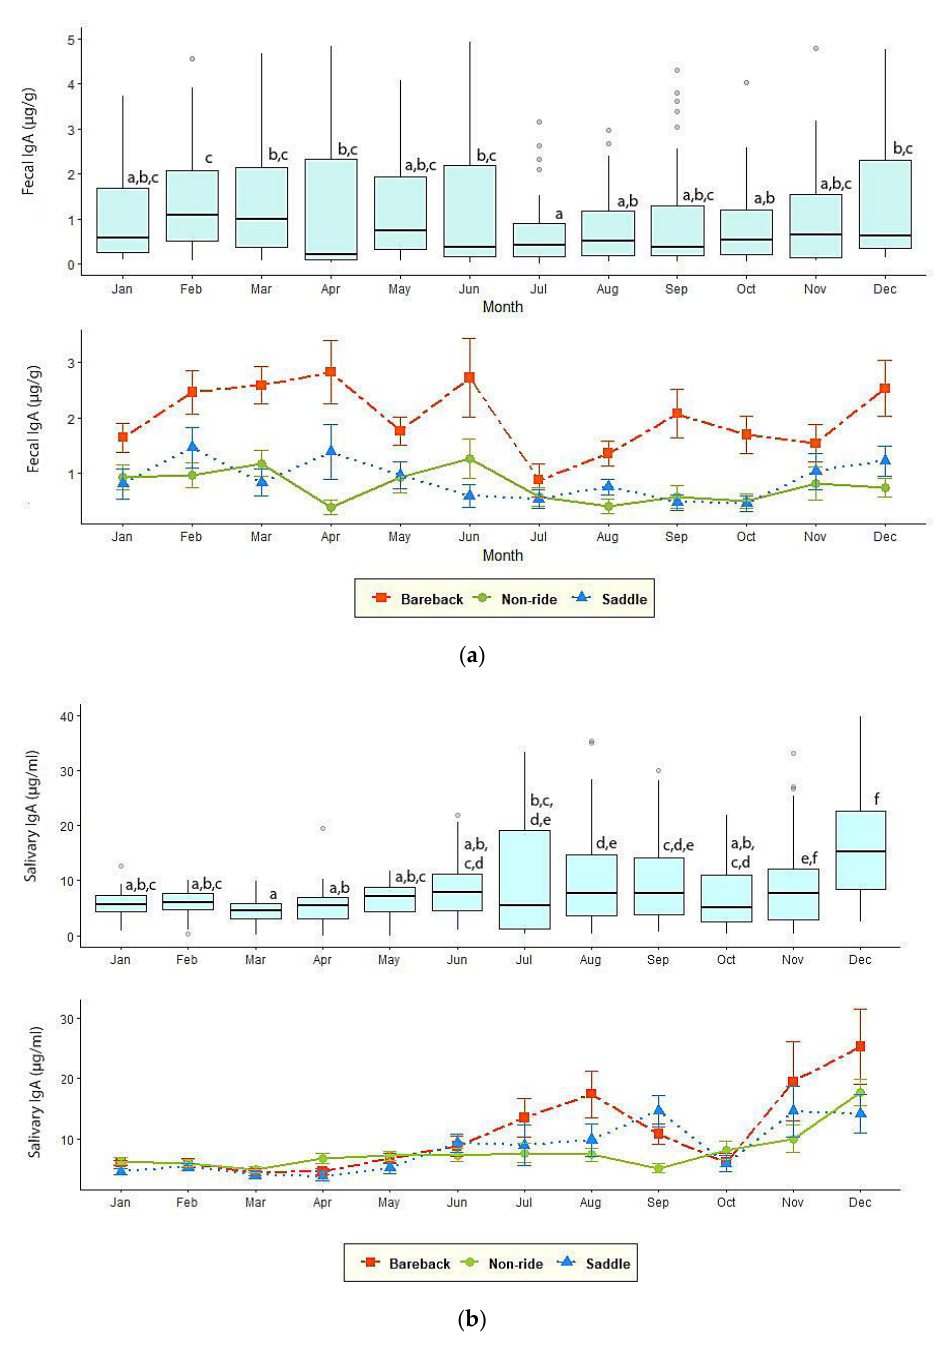
Figure 2. Mean (±SEM) of ( a ) fecal (µg/g) and ( b ) salivary (µg/mL) IgA concentrations in each elephant activity group. Box plot showed overall fecal and salivary IgA measures in combination with three elephant groups (N = 44). Whiskers represent median, quartiles, and the 25th/75th percentiles, error bars represent the 10th/90th percentiles, and open circles indicate outliers. Different superscripts indicate a significant difference at p < 0.05.